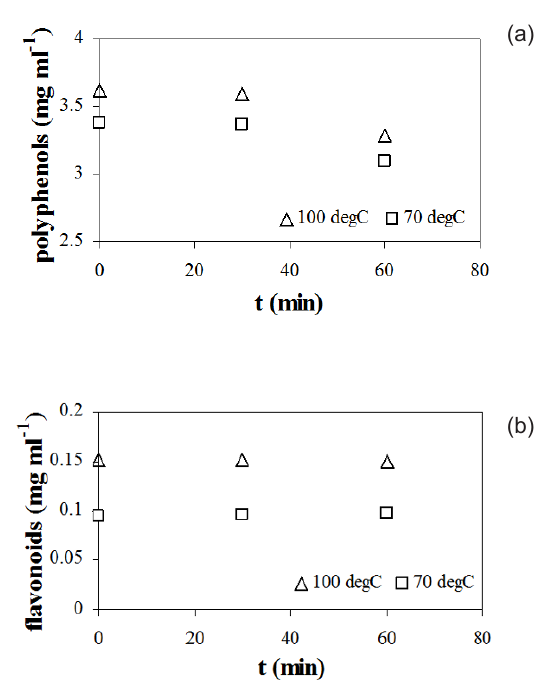
Figure 4. Concentration changes in extracts obtained at 70 o C and 100 o C in the course of one hour of additional boiling.